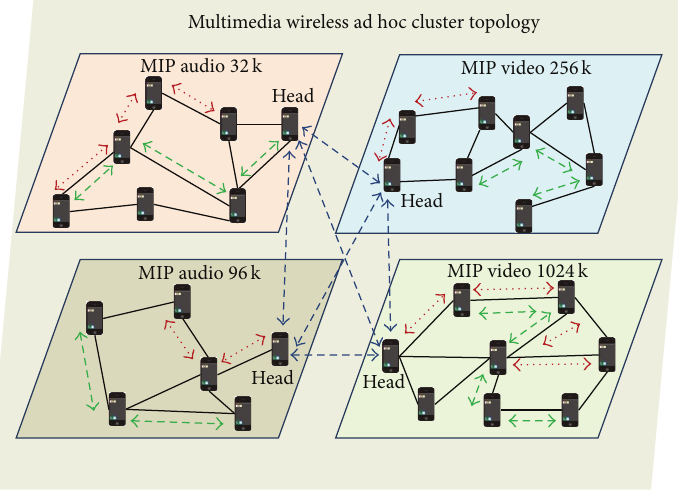
Figure 1: Multimedia ad hoc cluster topology.